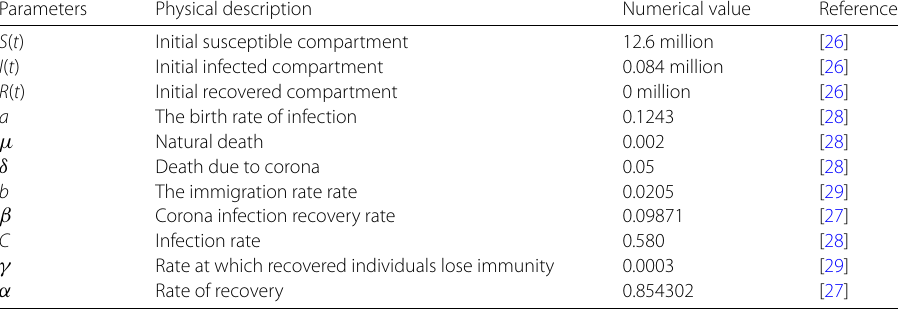
Table 2 The physical interpretation of the parameters and numerical values